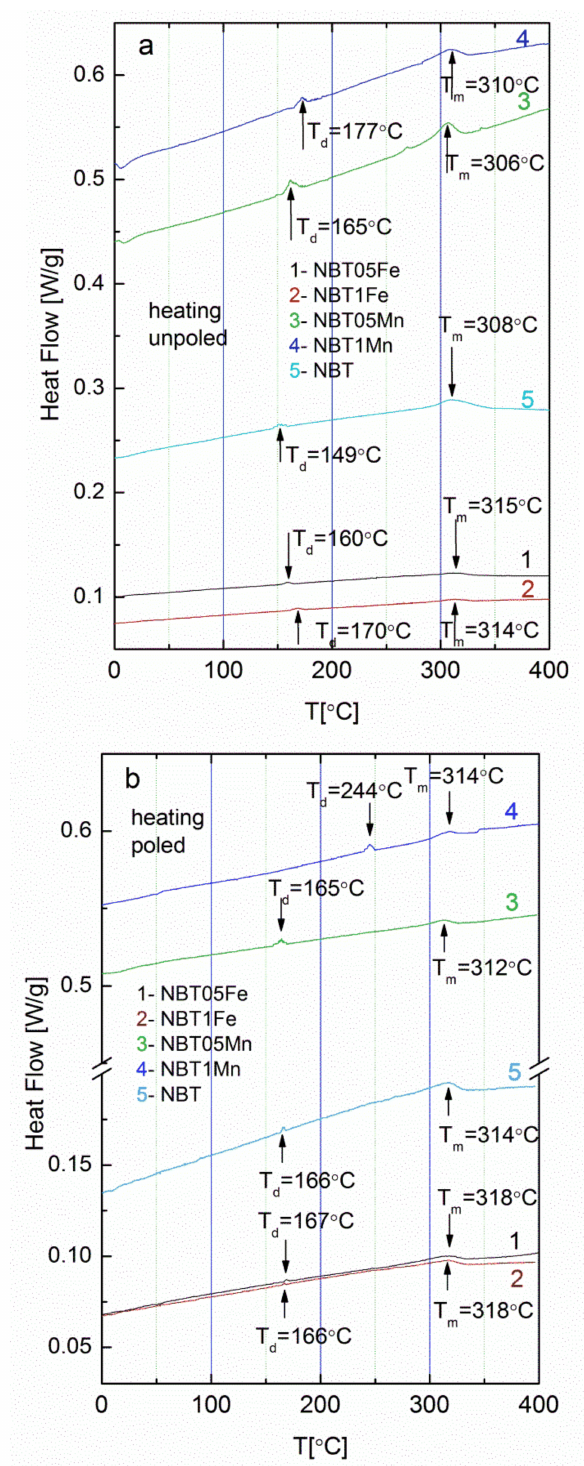
Figure 5. DSC curves of ( a ) unpoled and ( b ) poled samples. The DC electric conductivity ( σ DC ) increased as a result of the Fe and Mn incorporation to the NBT (Figure